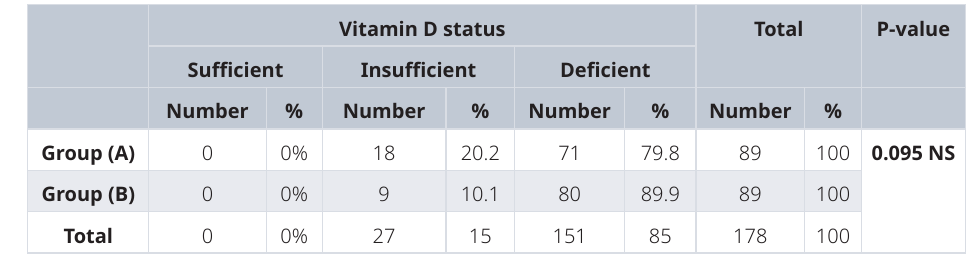
Table 2. Vitamin D status among the studied groups.